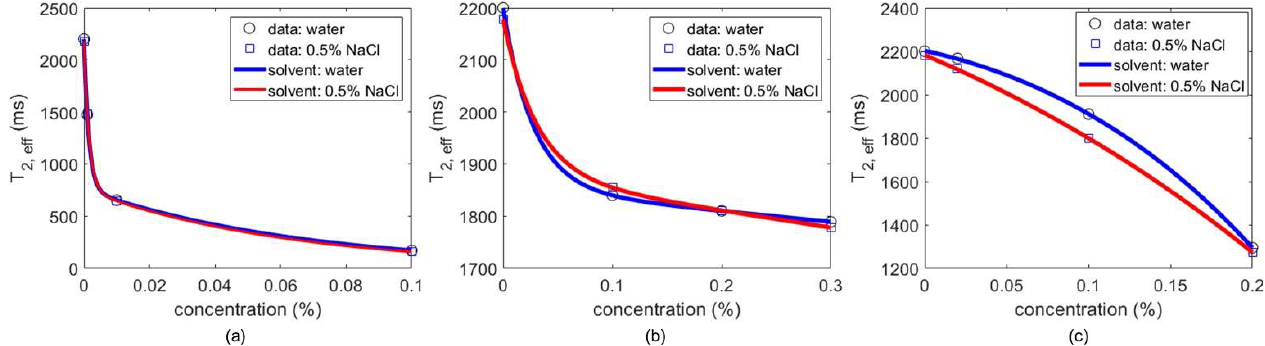
Figure 4. A library of vegetable dyes was created using the relationship between T 2, eff and its concentration. This library can be used to quantify the amount of dye used in vegetable adulteration. The libraries exhibiting these trends are shown for 3 different dyes: ( a ) copper sulfate, ( b ) malachite green, and ( c ) Sudan red. Separate library functions are shown for two different experimental solvents, namely DI water and 0.5% NaCl solution.